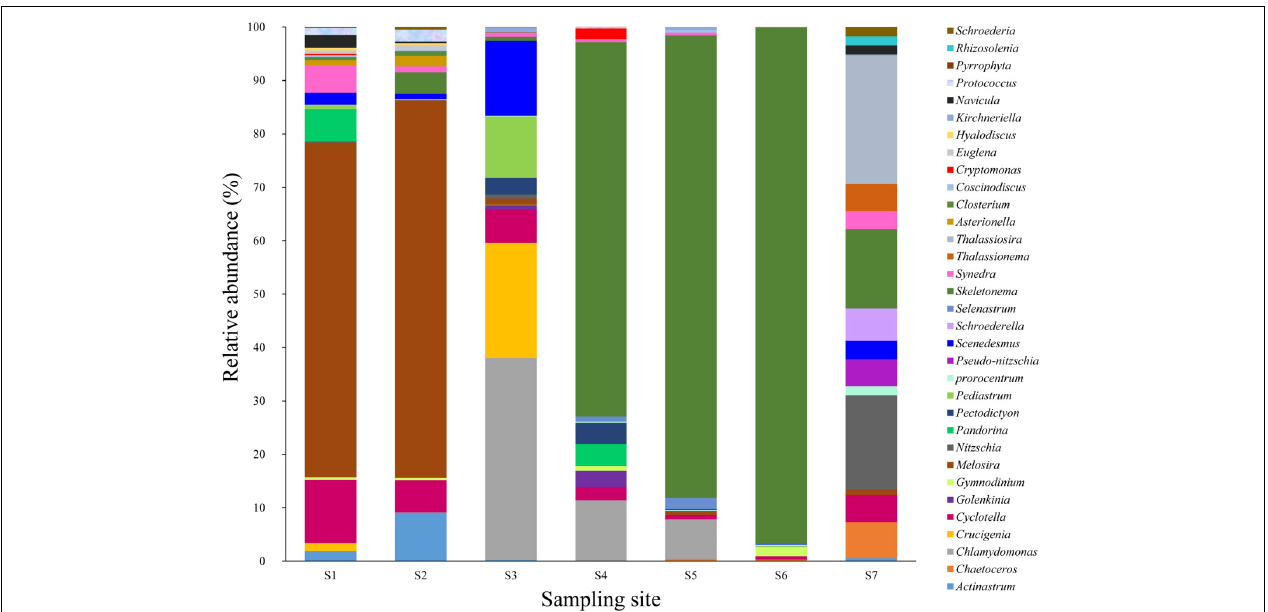
FIGURE 1 | Microalgal composition (at the genus level) at all surface sampling sites. Y -axis represents the relative abundance of microalgae. X -axis represents the sampling